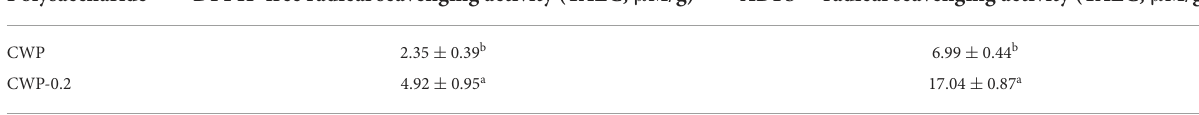
TABLE 4 The antioxidant activity of CWP and CWP-0.2. Polysaccharide DPPH · free radical scavenging activity (TAEC, µ M/g) ABTS · + radical scavenging activity (TAEC, µ M/g) CWP 2.35 ± 0.39